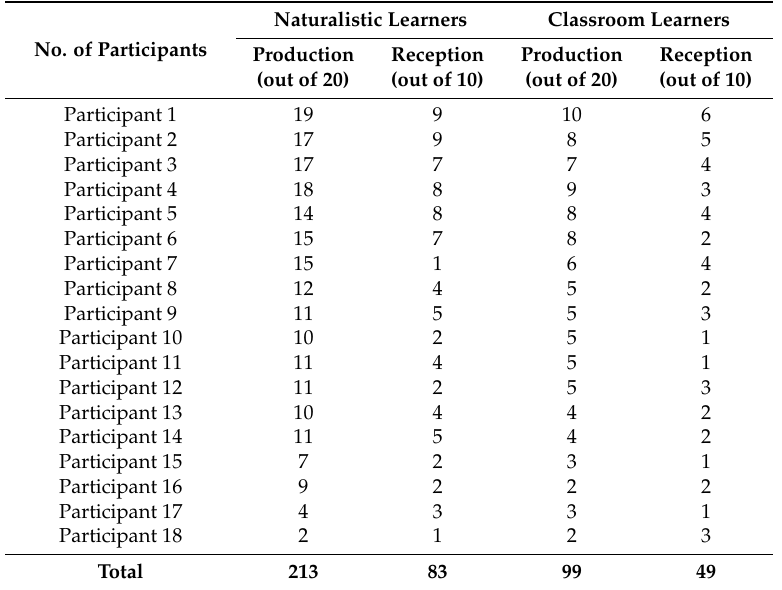
Table 2. The Correct Answers from Classroom and Naturalistic Learners on the Two